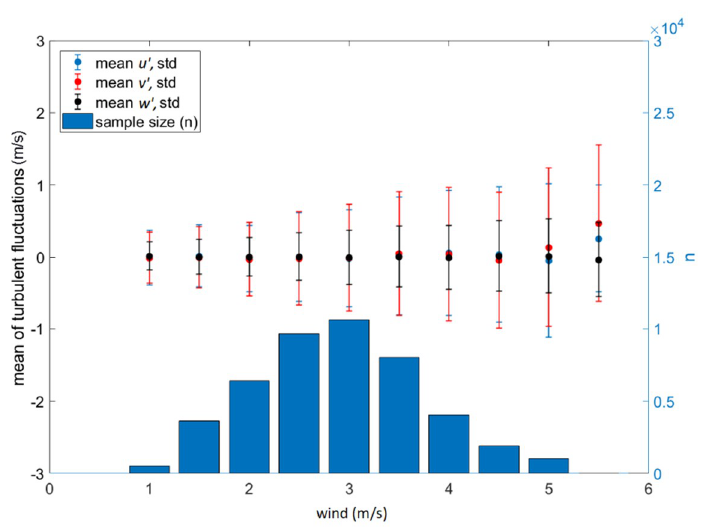
Figure 4. Mean values and standard deviations of turbulent fluctuations (left-hand axis) and sample size (right-hand axis) for each wind class, measured by a 3D sonic anemometer at the Nafferton (U.K.) field test site.